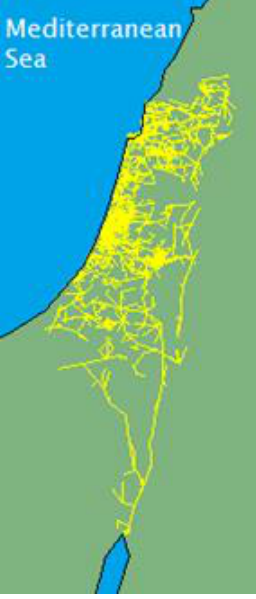
Figure A1. Israel’s surroundings. The yellow lines show the distribution of Cellcom’s CMLs [13].